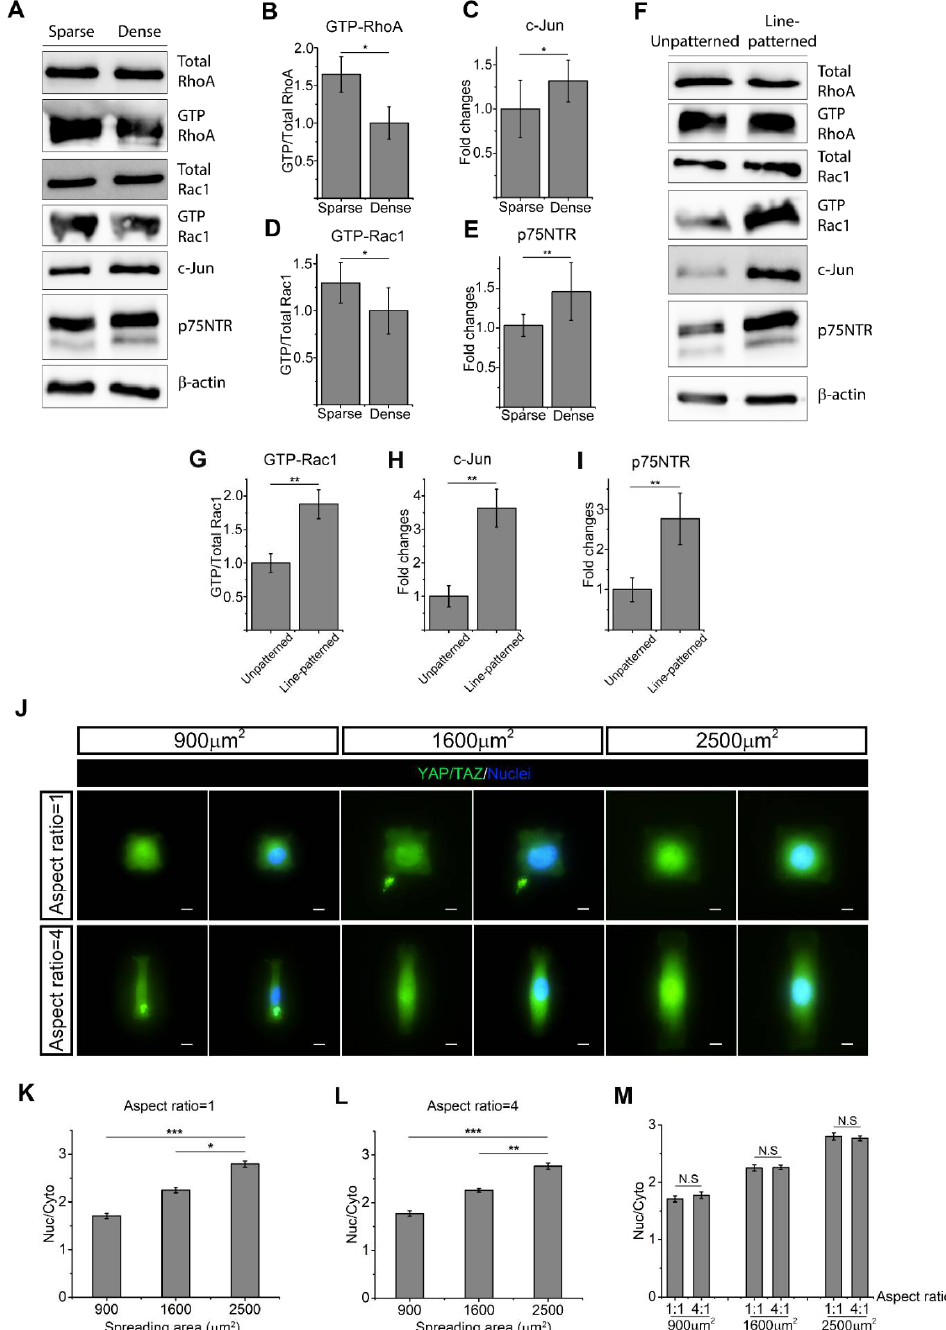
Figure 3. Schwann cell (SC) morphology regulates the expression of active RhoA, Rac1 and YAP/TAZ. ( A – E ) Western blot quantification of SCs show RhoA, Rac1, c-Jun, and p75NTR expression of different cell spreading areas. Four cell lysates were created for Western blot quantification. ( F – I ) Western blot quantification of SCs shows RhoA, Rac1, c-Jun, and p75NTR expression of different extents of cell elongation. Three cell lysates were created for Western blot quantification. ( J ) Immunofluorescent staining of micropatterned SCs shows nuclear (active) YAP/TAZ (green) with different spreading areas and extents of elongation. Scale bar = 10 µ m. ( K , L ) When the extent of cell elongation is constant, active YAP/TAZ declines as cell spreading area decreases. ( M ) When SCs process the same spreading area, active YAP/TAZ cannot be regulated by the extent of cell elongation. For YAP/TAZ quantification of micropatterned SCs, 3 unique trials with a minimum of 89 single micropatterned SCs per trial were quantified. Data are presented as the mean ± SEM. * p < 0.05, ** p < 0.005, *** p < 0.0005, p -values found in Supplemental Table